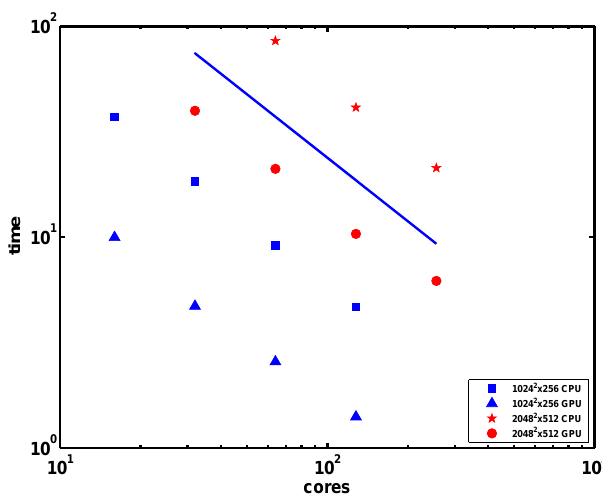
Figure 5. Traditional strong scaling plot for anisotropic Boussinesq solves, comparing the CPU-only and GPU aggregate times for two different sets of Boussinesq runs distinguished by their resolutions (see legend), on the SummitDev NVLink system. The reference line indicates ideal scaling.